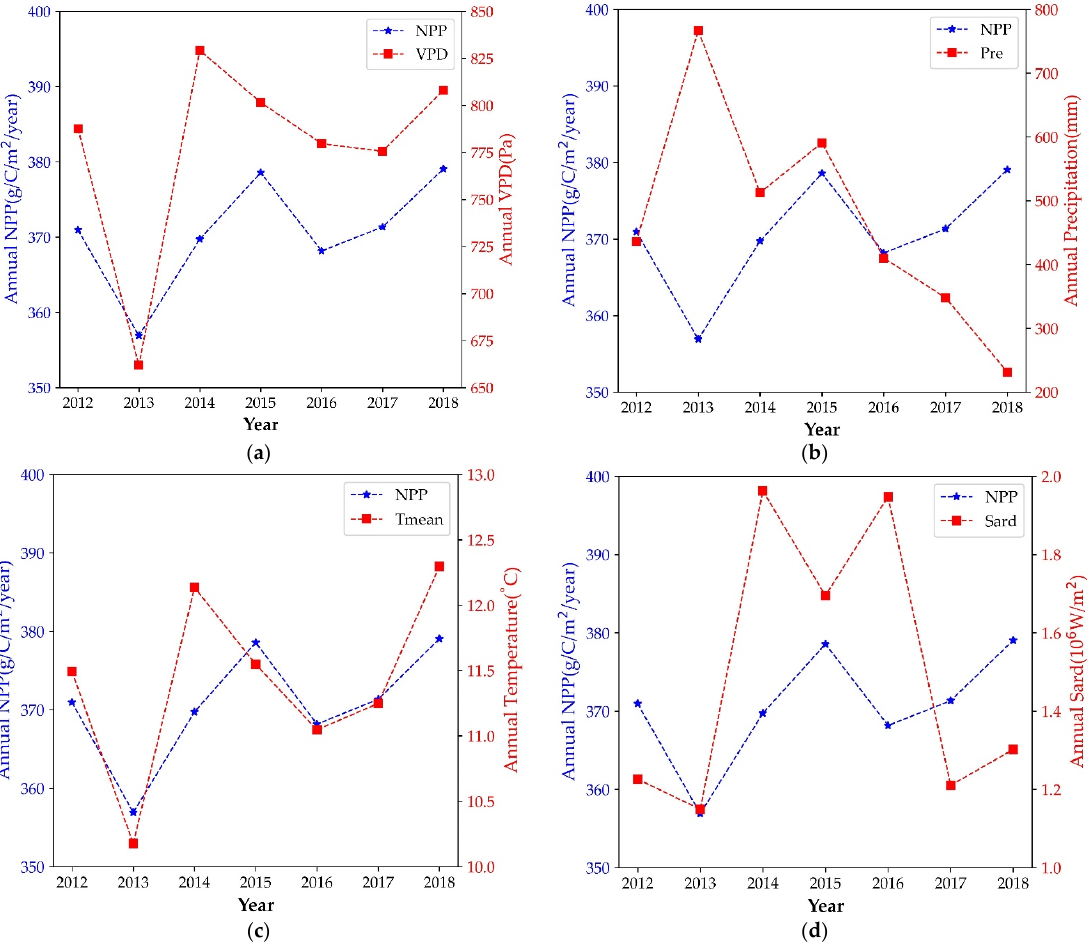
Figure 10. Interannual NPP and meteorological data statistics for the growing seasons in forested areas over the Greater Khingan Mountains in Inner Mongolia.